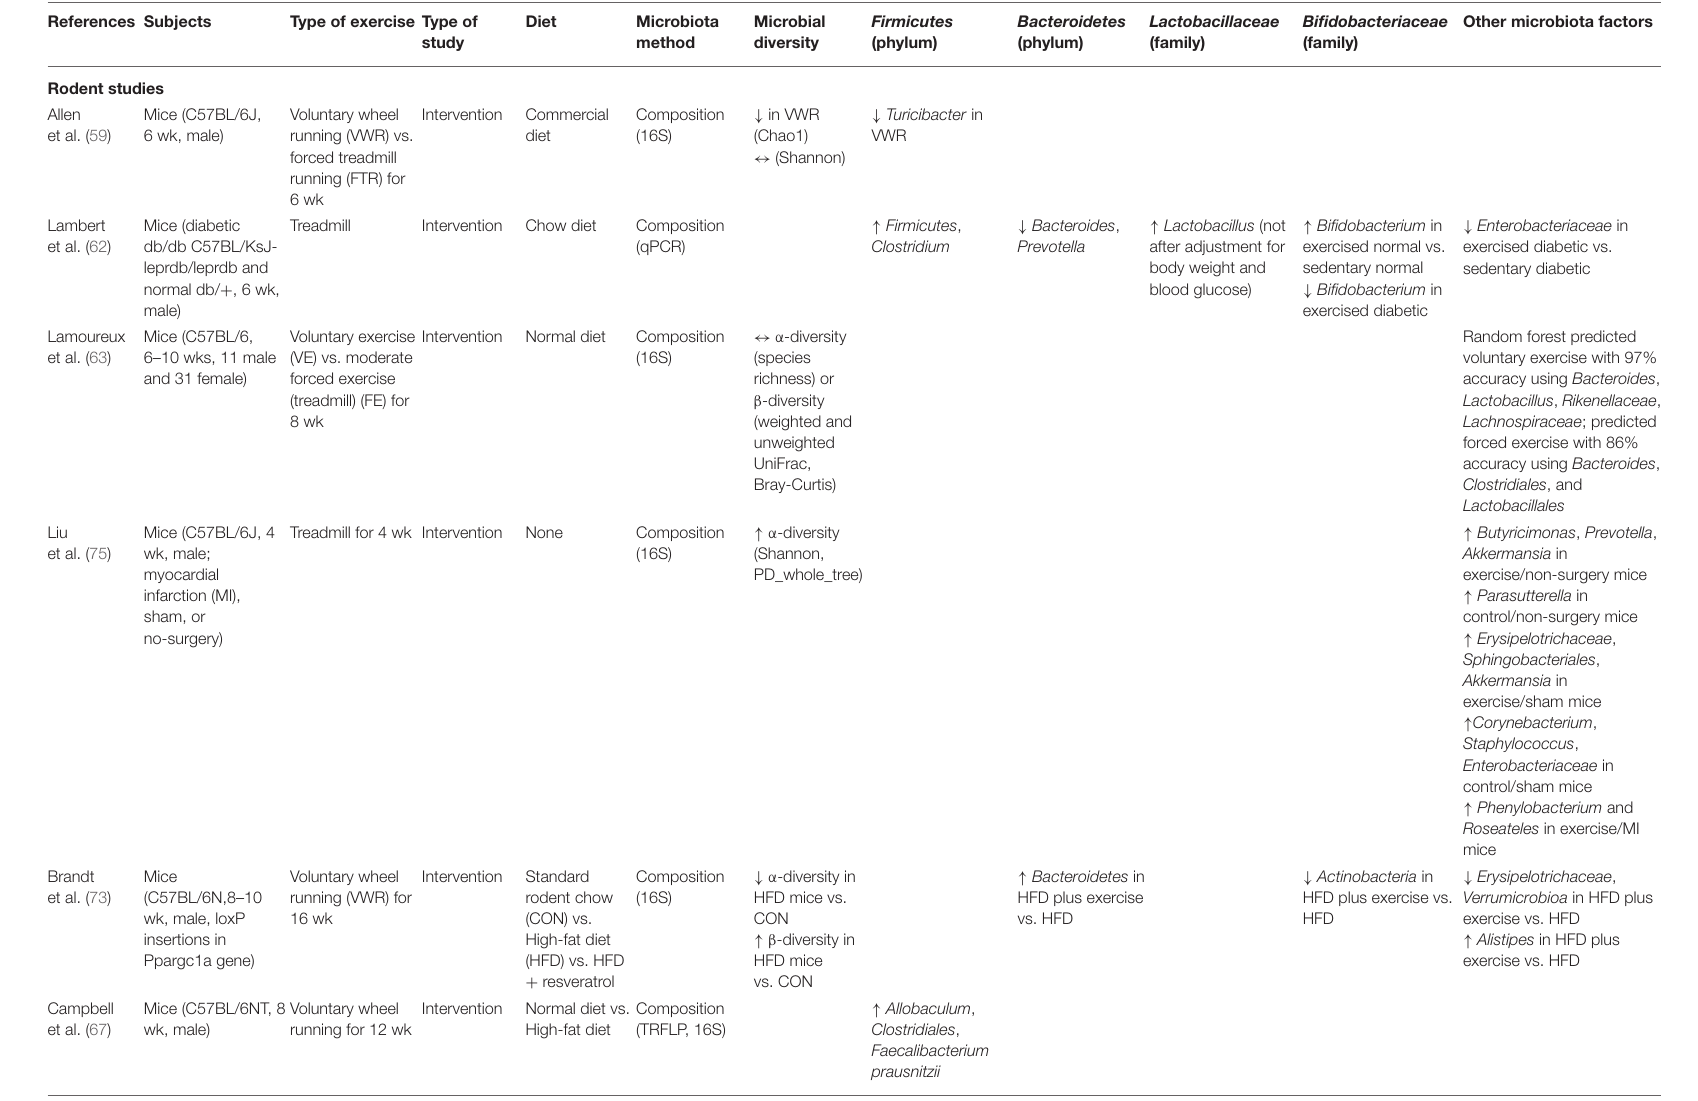
TABLE 1 | Summary of effect of exercise on the gut